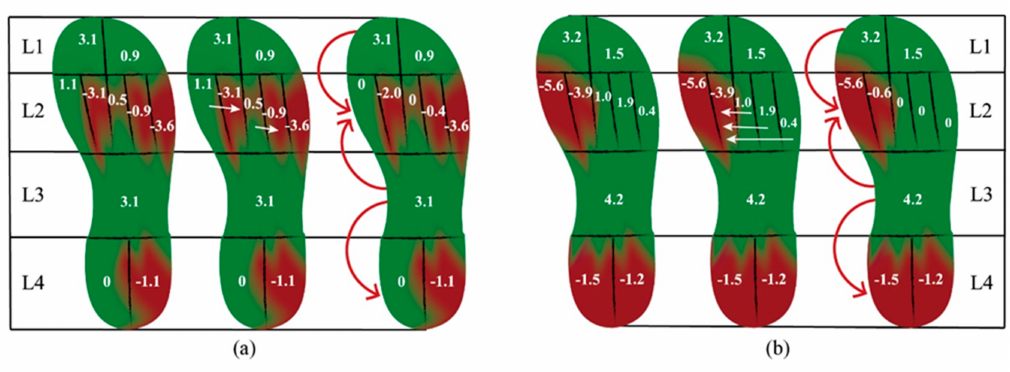
Figure 2. Age-related loading transferences in ( a ) obese children and ( b ) normal-weighted